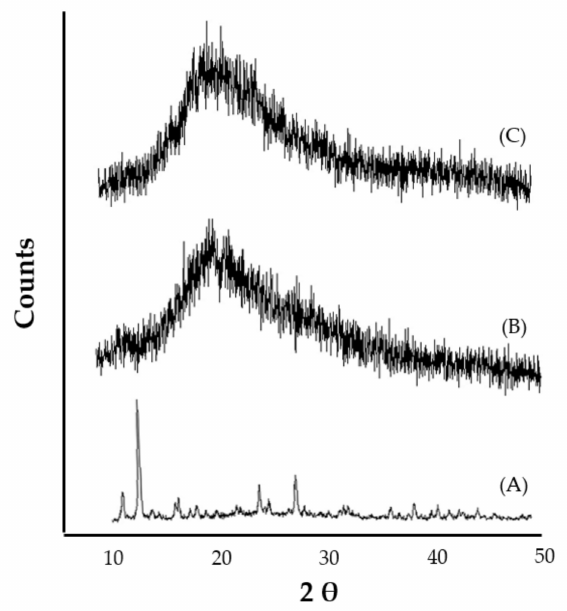
Figure 5. X-ray diffractograms of ( A ) silymarin; ( B ) SPC; and ( C ) optimized silymarin phytosomal for- mulation.